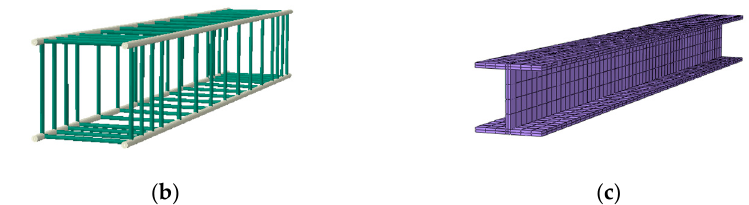
Figure 11. The establishment of the finite element model: ( a ) the concrete part; ( b ) the rebar part; ( c ) the section steel.